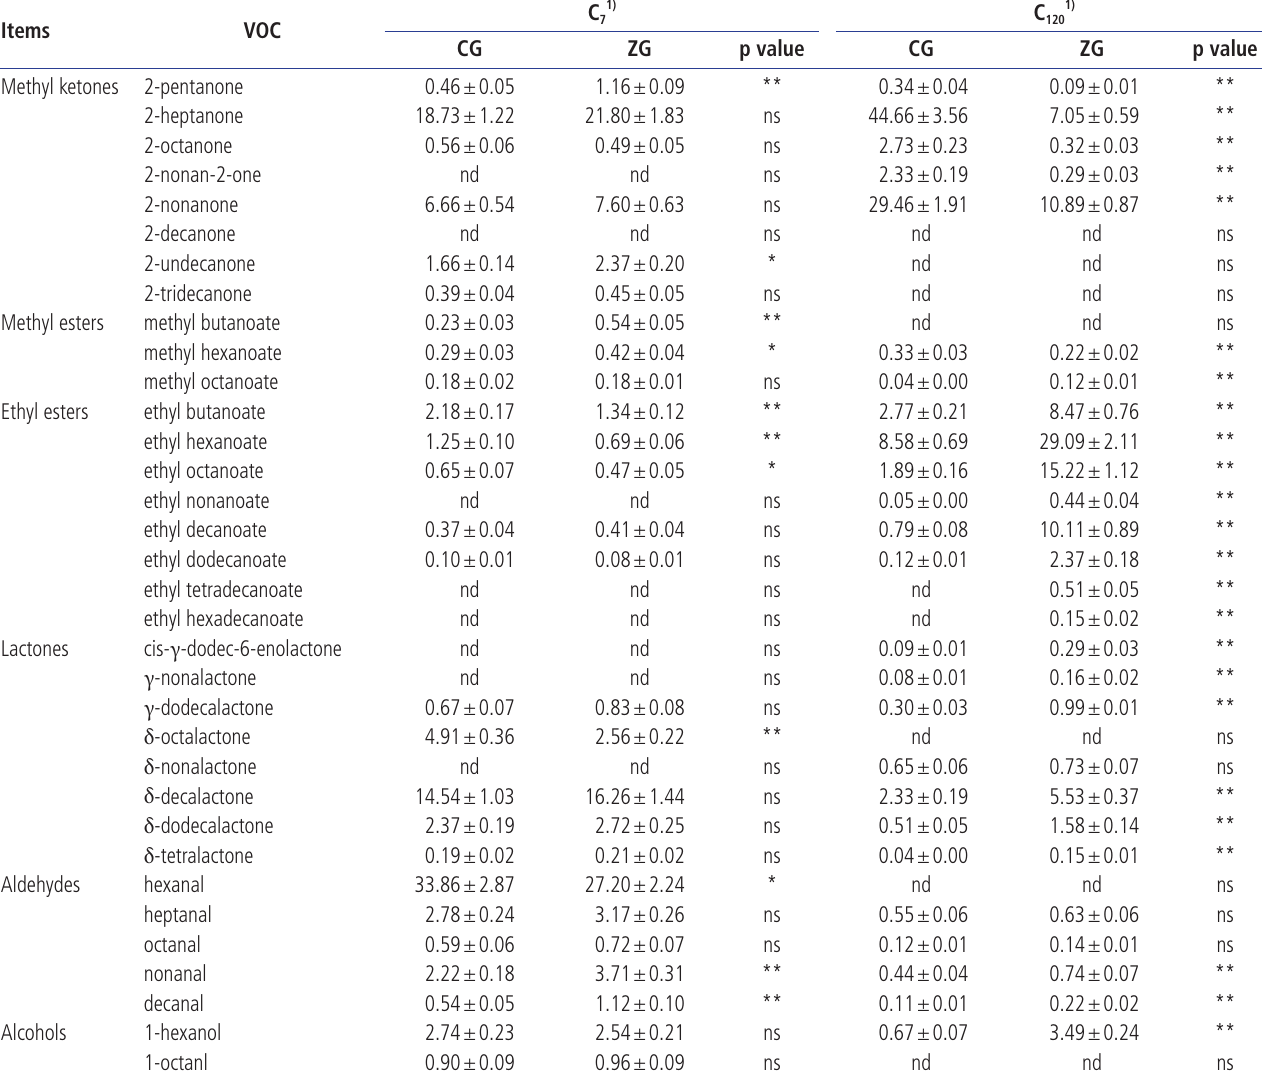
and C cheese samples obtained from control and experimental group 7 120